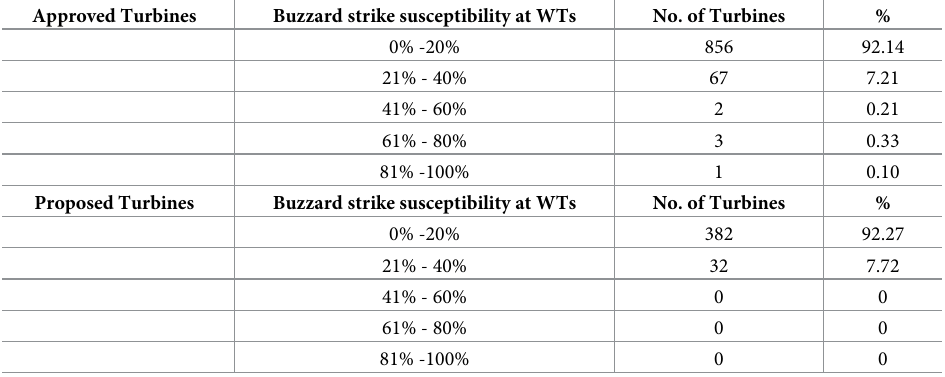
Table 4. Turbines in the approved and proposed phases of development in the federal state of Brandenburg planned across the Buzzard strike susceptibility